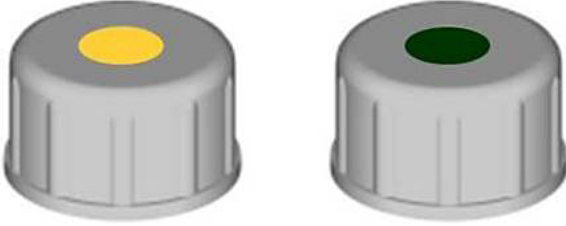
Figure 14. Time-monitoring sensor in a polymer bottle cap, that shows the expired shelf life time before (left) and after (right) first opening.